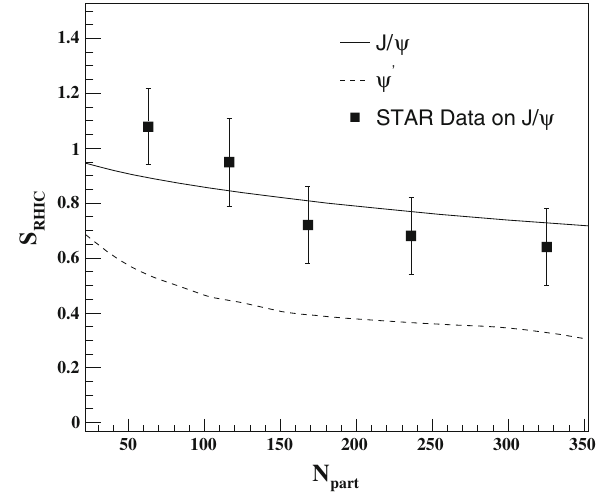
Fig. 20 Variation of survival probability (S) of J /ψ and ψ (cid:8) with respect to N part at center of mass energy mental Data is taken from Ref. [52]